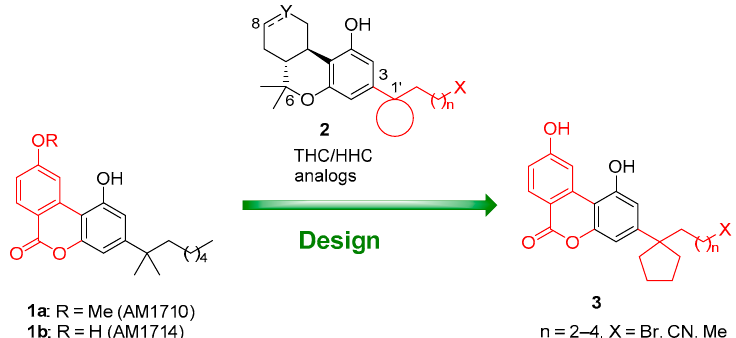
Figure 1. Design of chain substituted cannabilactones and structures of the first-generation analogs AM1710 and AM1714.